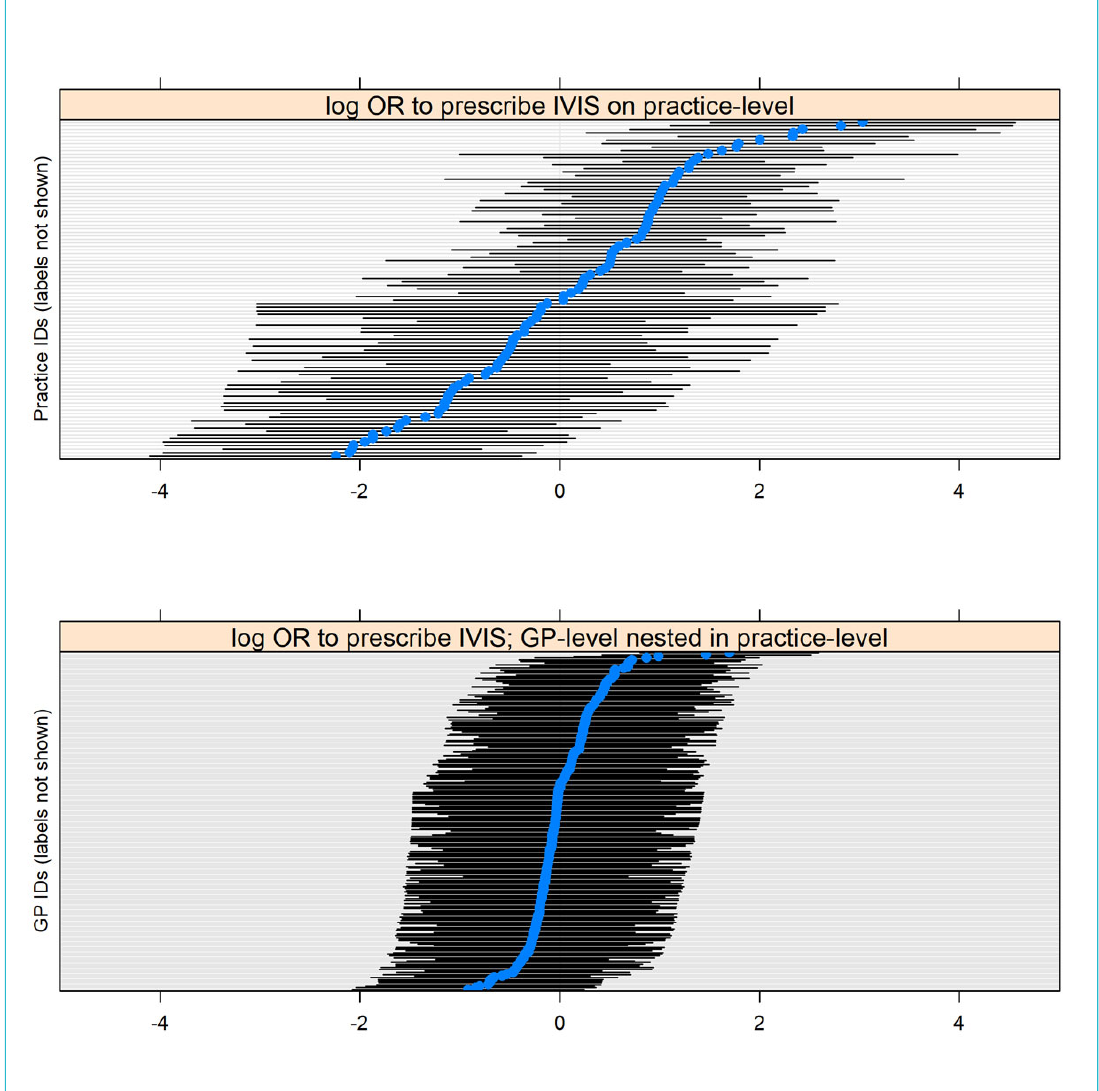
Figure S1: Log odds ratios and 95% confidence intervals of practices and GPs nested in practices for prescription of IVIS instead of OIS. OIS = oral iron supplementation; IVIS = intravenous iron supplementation; GP = general practitioners; OR = odds